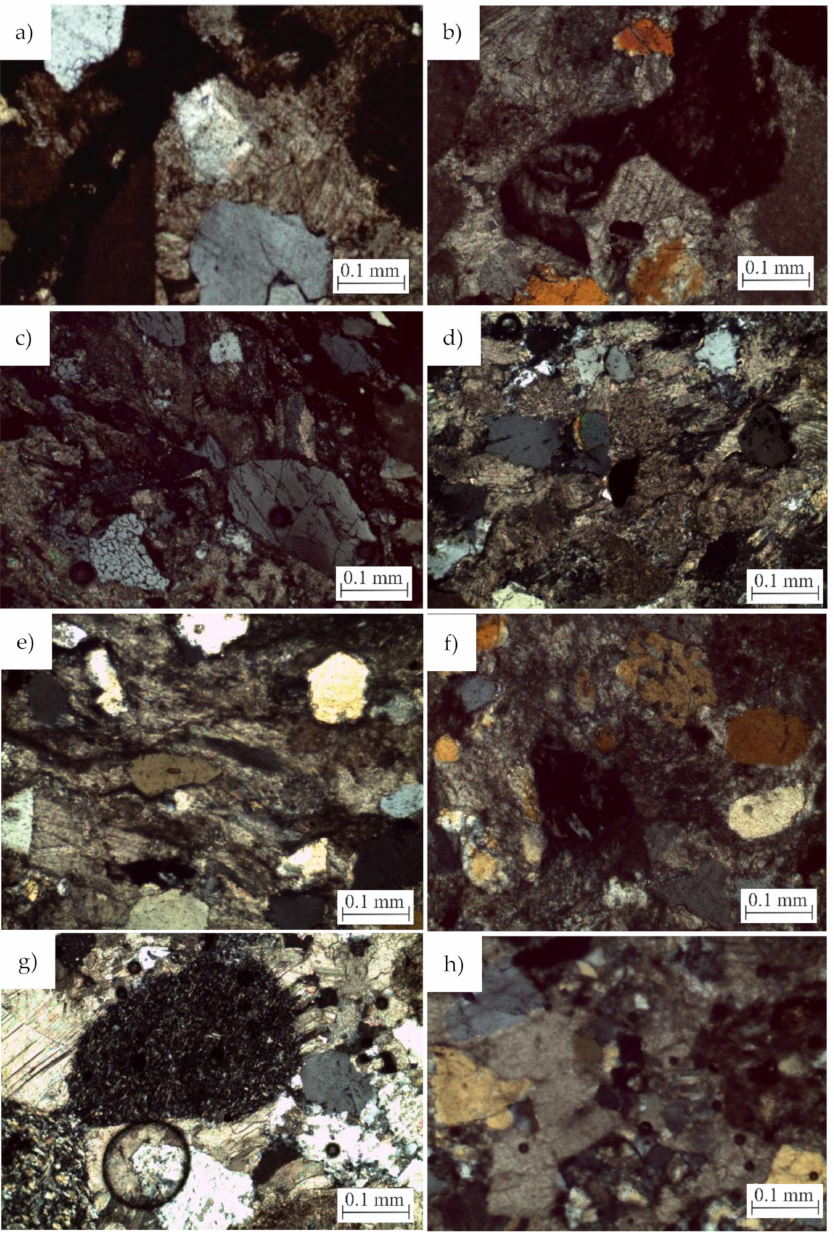
Figure 9. Photomicrograph showing ( a , b ) hematite, ( c ) rutile, ( d ) biotite, ( e ) zircon, ( f ) fluid inclusion in quartz, ( g ) volcanic clast, and ( h ) hematite clast in the litharenite. The matrix ranges from 2–13%. Calcite (Figure 8c,g–i), hematite (Figure